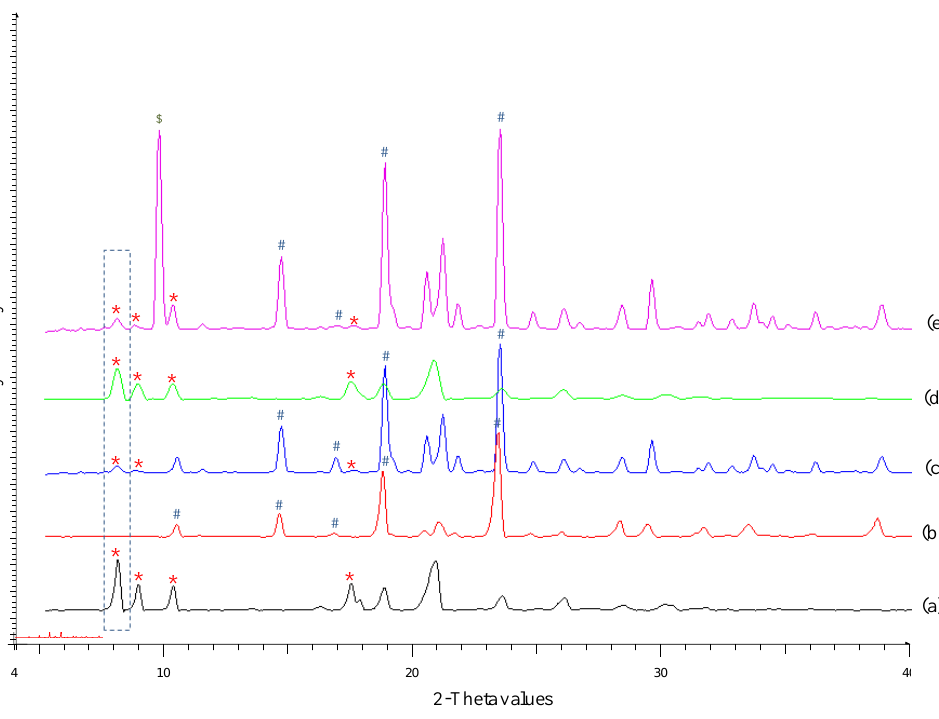
Figure 2. An overlay of X-ray diffractograms of ( a ) DPM ( b ) MAN ( c ) DPM-MAN PM ( d ) NS and ( e ) NSD. The characteristic peaks have been marked with symbols *, # and $ for DPM, β-form of MAN and δ-form of MAN, respectively. The characteristic peak of DPM at 8.1° 2θ value has been marked with a dotted box.